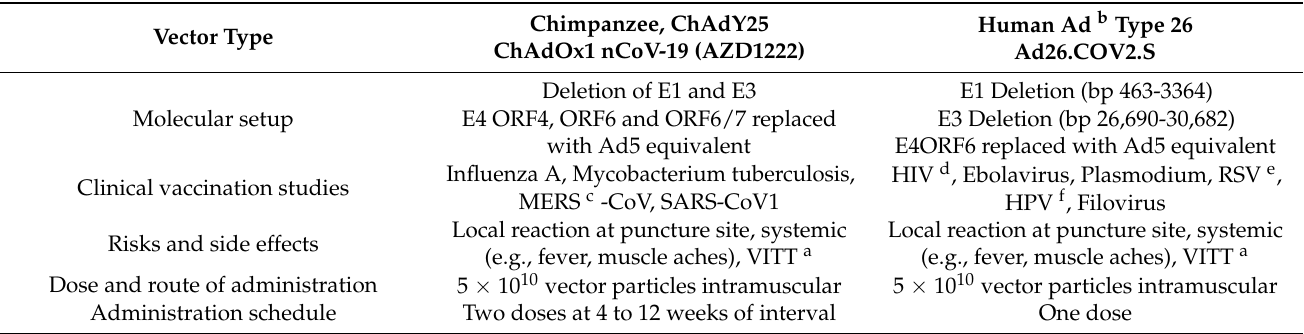
Table 2. Features of ChAdOx1 and Ad26.COV2.S as vaccine vectors in the COVID-19 pandemic. Summarized are the molecular features, clinical studies, risks and side